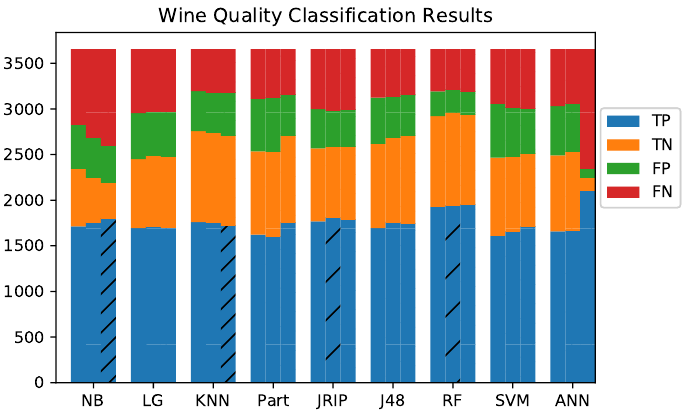
Figure A7. Graph corresponding to the Pima Indians Diabetes dataset. In blue are true positives, in orange are true negatives, in green are false positives, in red are false negatives, and in purple are unclassified instances.